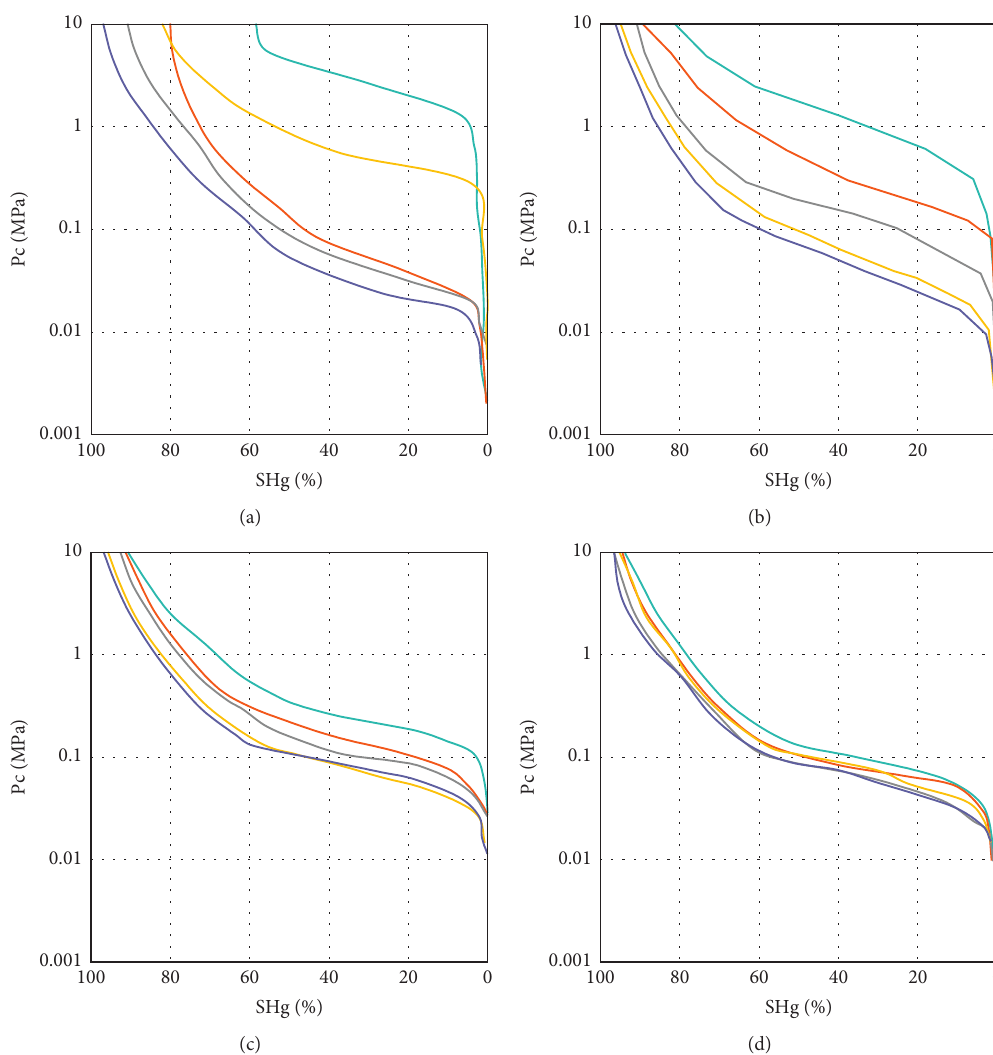
Figure 3: Mean capillary pressure curve. (a) K 71 . (b) K 72 . (c) K 73 . (d) K 74